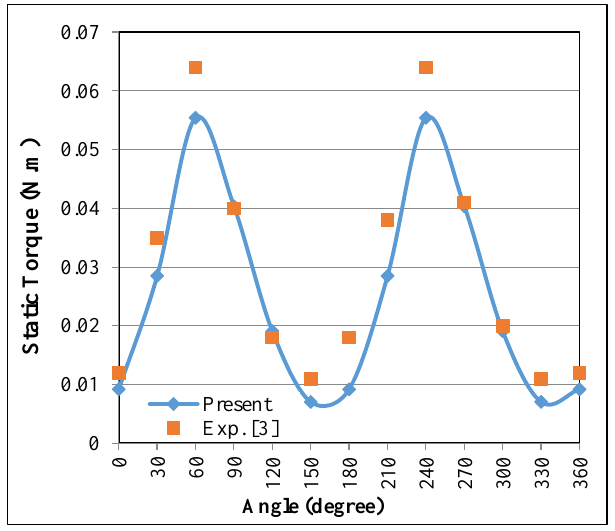
Figure 21. Relation between static torque and the rotation angle for the IceWind turbine at an air velocity of 15.8 m/s in the numerical and experimental [3] studies.